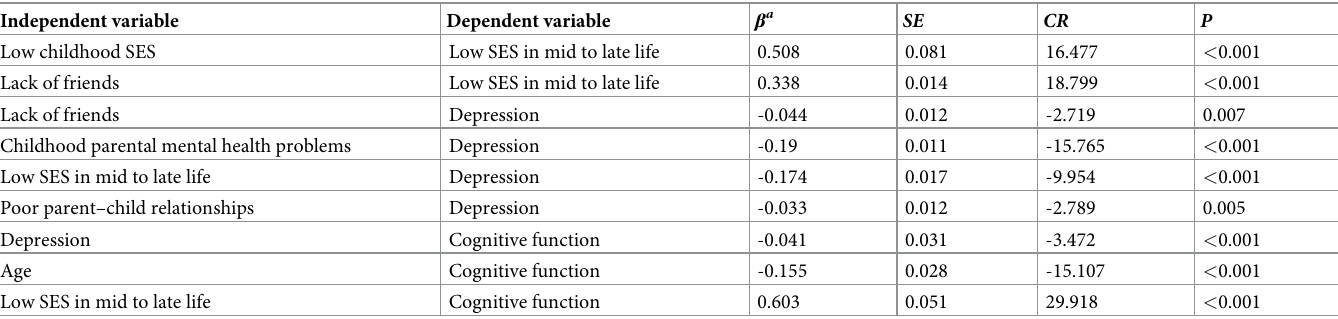
Table 2. Path coefficients and standard errors for the final SEM model (N =